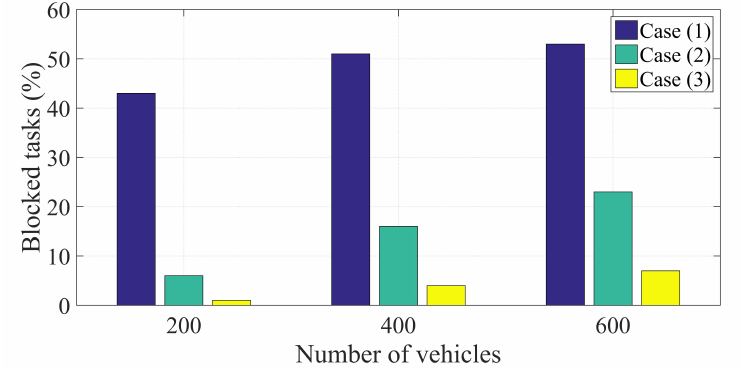
Figure 6. Average percentage of blocked tasks for different values of deployed vehicles.